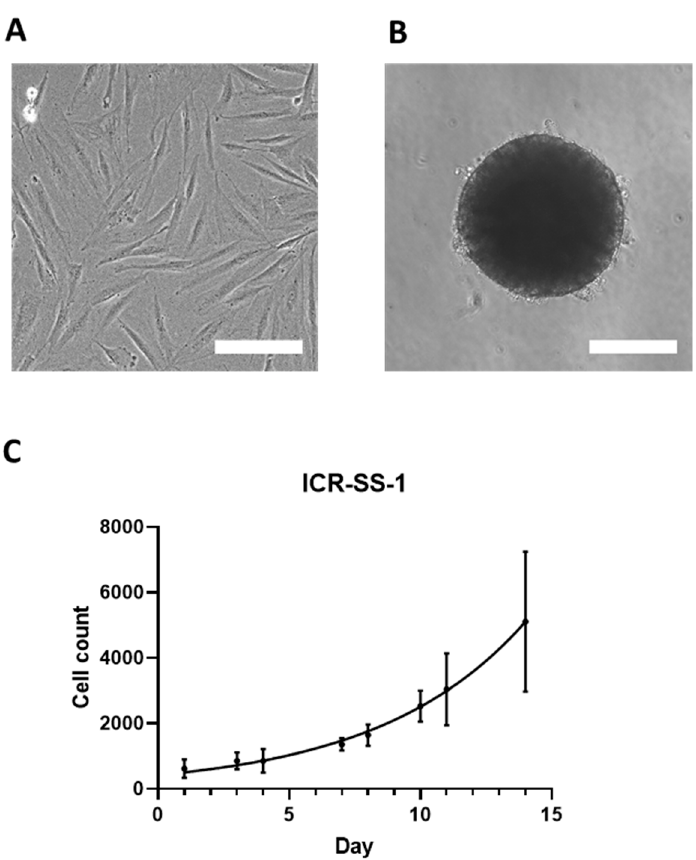
Figure 3. ( A ) Phase-contrast image of ICR-SS-1 cells in 2D. Scale bar = 200 µm. ( B ) Brightfield image of ICR-SS-1 spheroid. Scale bar = 200 µm. ( C ) Cell count of ICR-SS-1 cell line over 14 days. N = 3.